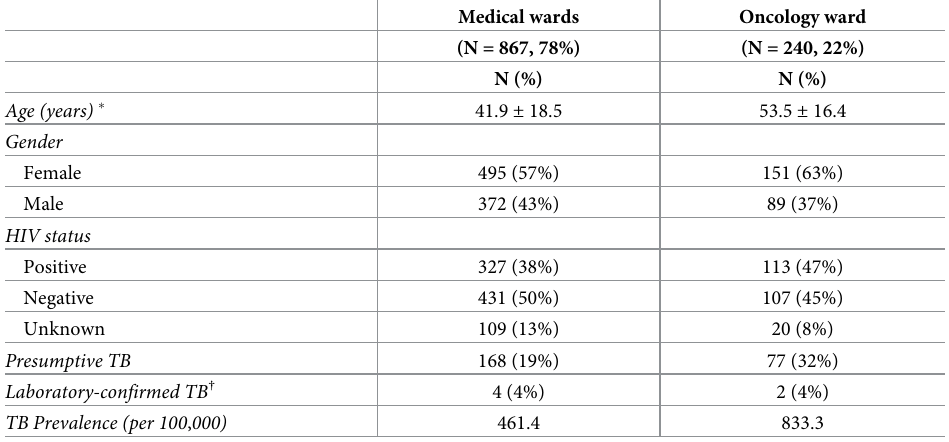
Table 1. Characteristics of study population who were screened for presumptive tuberculosis symptoms between August 2016 and June 2017 (N = 1107). Medical